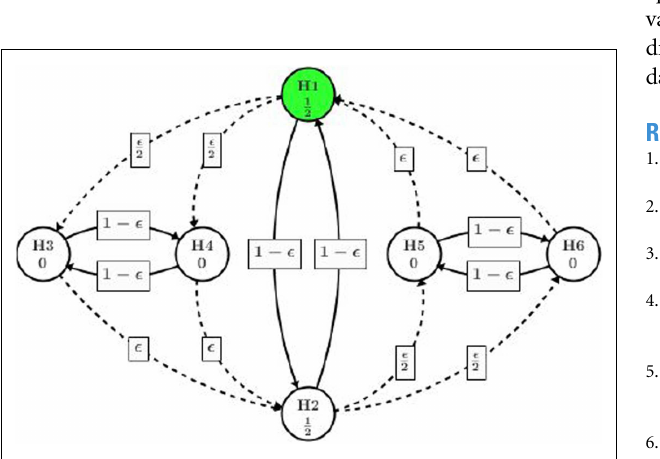
FIGURE 5 | Direct path between H 1 and H 2